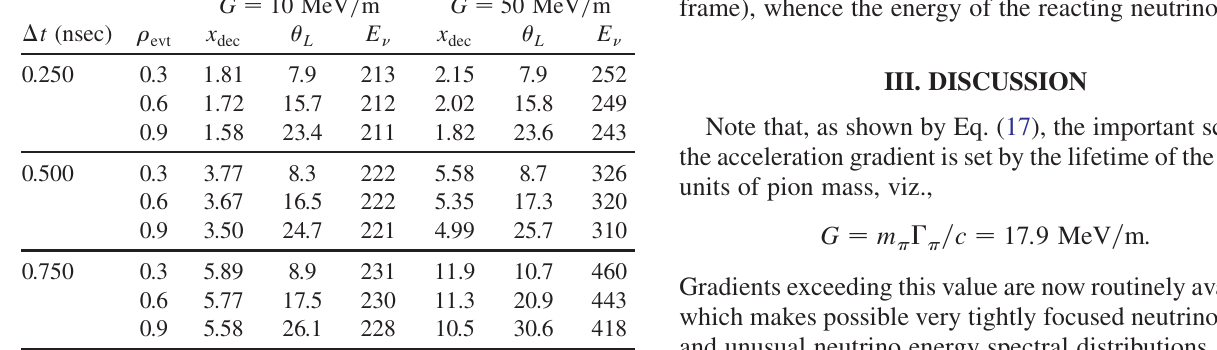
TABLE II. Extractions of the decay point x dec (in m), neutrino (in mrad), and E (in MeV) for a scattering laboratory angle (cid:7) L (cid:1) event taking place at various scattering times (cid:2) t in the detector at three values of off-axis radial position (cid:8) evt . This case is for an event occurring in the detector at x evt ¼ 40 : 0 m from the accel- ¼ erator injection point. We have assumed here that T (cid:3) 350 MeV at injection into PILAC, as in Table I. G ¼ 10 MeV = m